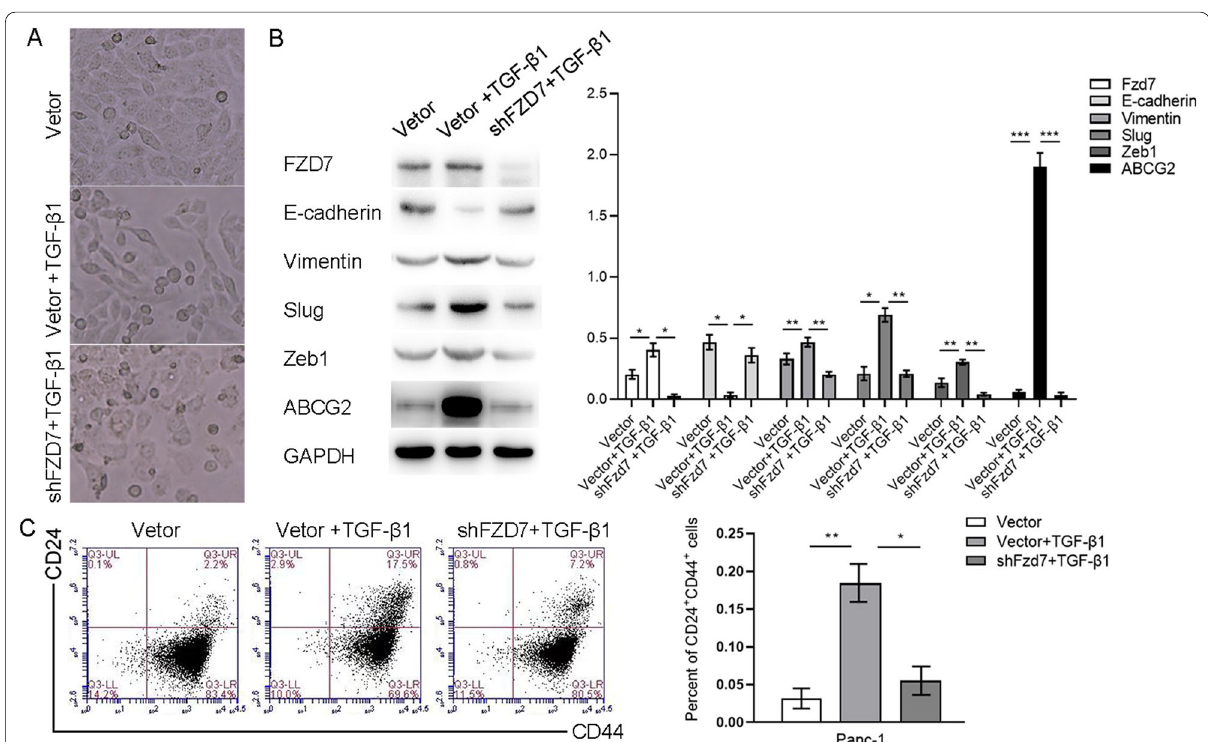
Fig. 6 After treatment of 10 ng/ml TGF-β1 for 48 h, PANC-1 cells acquired a fusiform and elongated morphology, while shFZD7-PANC-1 acquired no morphological change ( A ). Western blot showed that after the treatment of TGF-β1, Vimentin, Slug, Zeb1, ABCG2 expression were increased, similarly, TGF-β1 could not change these phenotype protein expression levels of shFZD7-PANC-1 ( B ). CD24 + CD44 + cells population representing CSC subsets were increased after treatment of TGF-β1, when FZD7 expression was silenced, this effect was attenuated ( C ). Significant, * P <